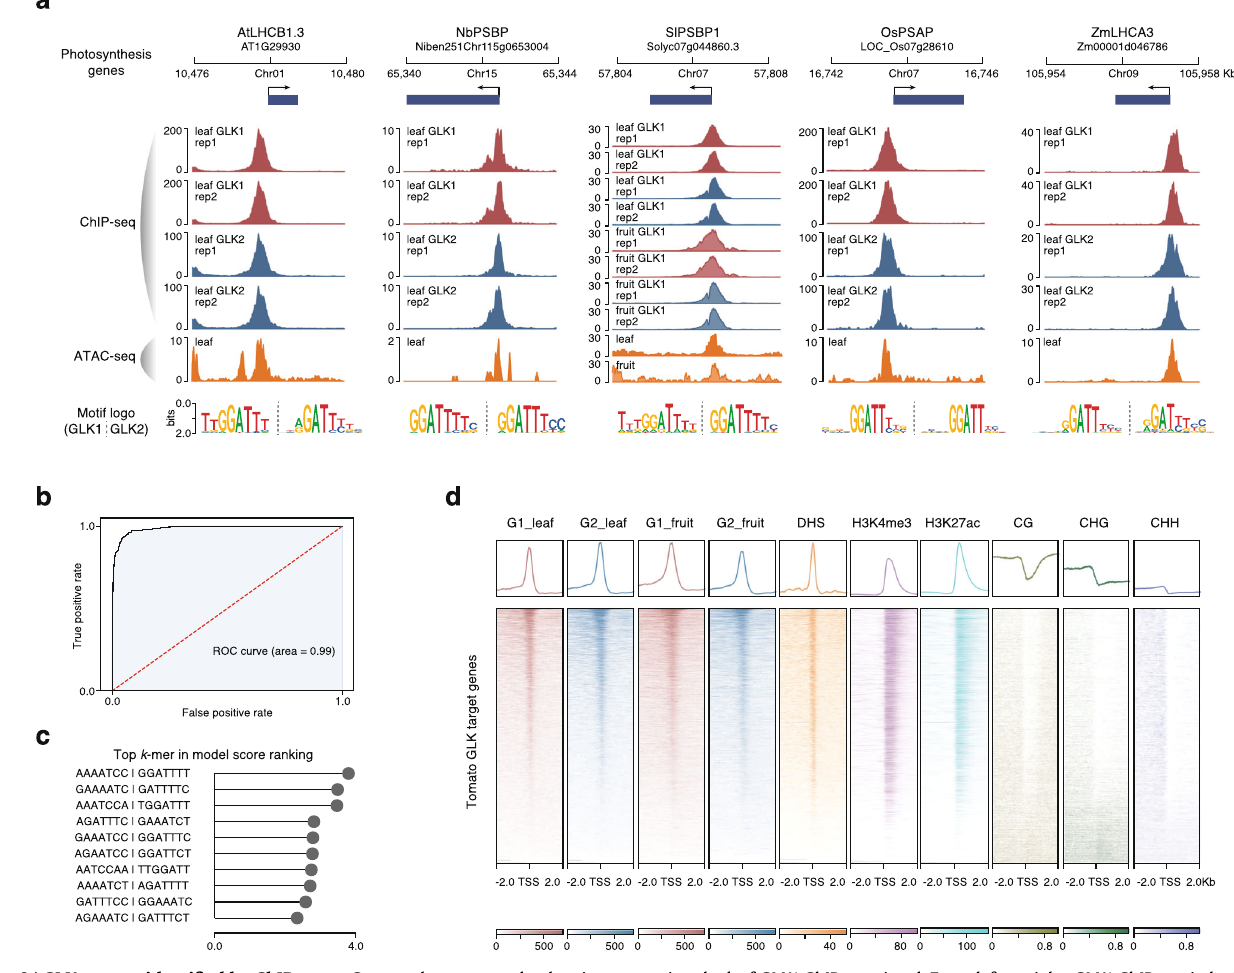
using the leaf GLK1 ChIP-seq signal. From left to right, GLK1 ChIP-seq in leaf, GLK2 ChIP-seq in leaf, GLK1 ChIP-seq in fruit, GLK2 ChIP-seq in fruit, chromatin accessi- bilityDNase-seqsignal,H3K4me3,H3K27ac,DNAmethylationatCG,CHGandCHH sites. Regions 2kb up and downstream of the gene transcriptional start sites are shown. Source data are provided as a Source Data fi